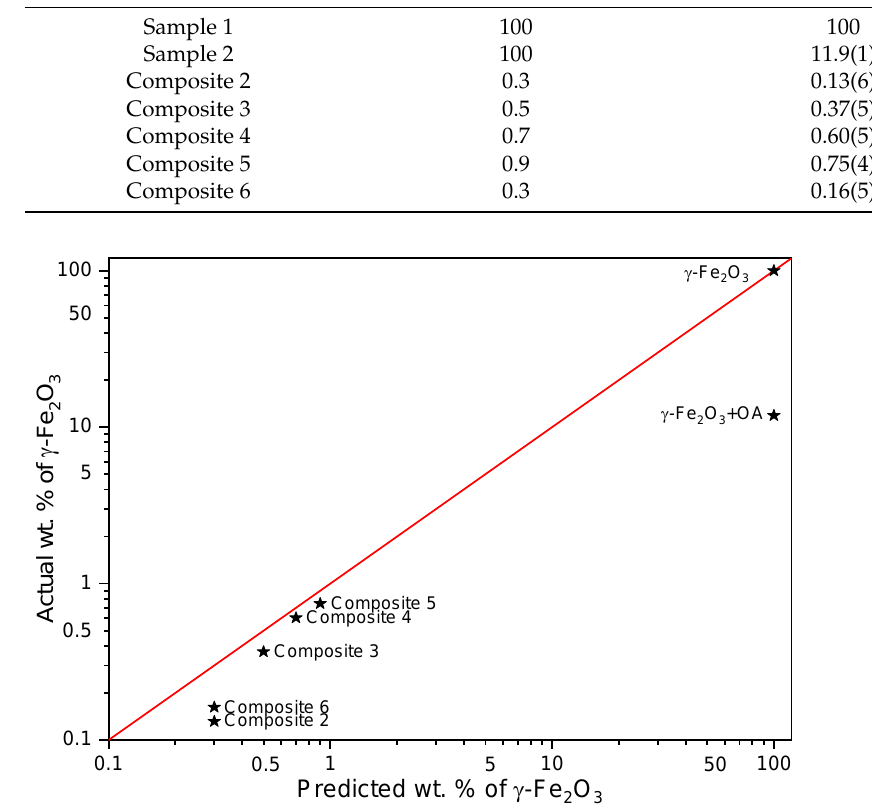
Figure 16. Predicted vs. estimated content of γ -Fe 2 O 3 nanoparticles in the Samples 1 – 2 and Compo- sites 2 –